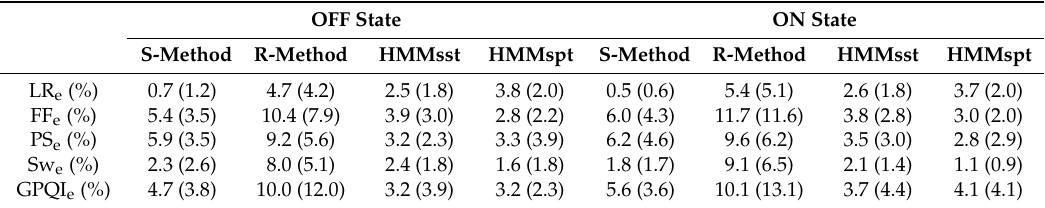
Table 4. Mean and Standard Deviation of absolute error in the estimation: Loading Response (LR), Flat-Foot (FF), Pre-Swing (PS), Swing (Sw) and GPQI both for OFF and ON state. OFF State ON